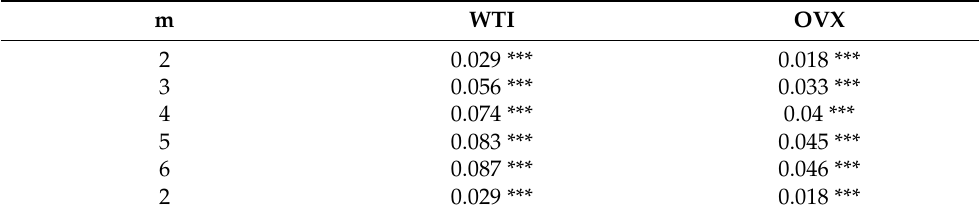
Table 1 . Summary statistics of returns series for WTI and OVX .